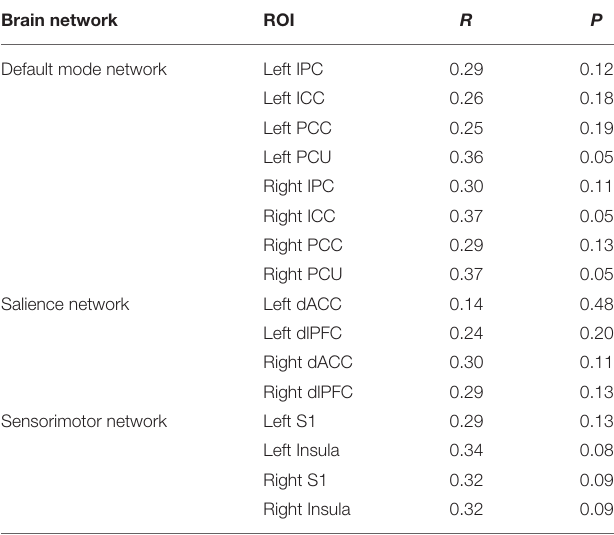
TABLE 3 | The relationship between change of VAS and brain features by using bivariate Pearson correlation analyses. Brain